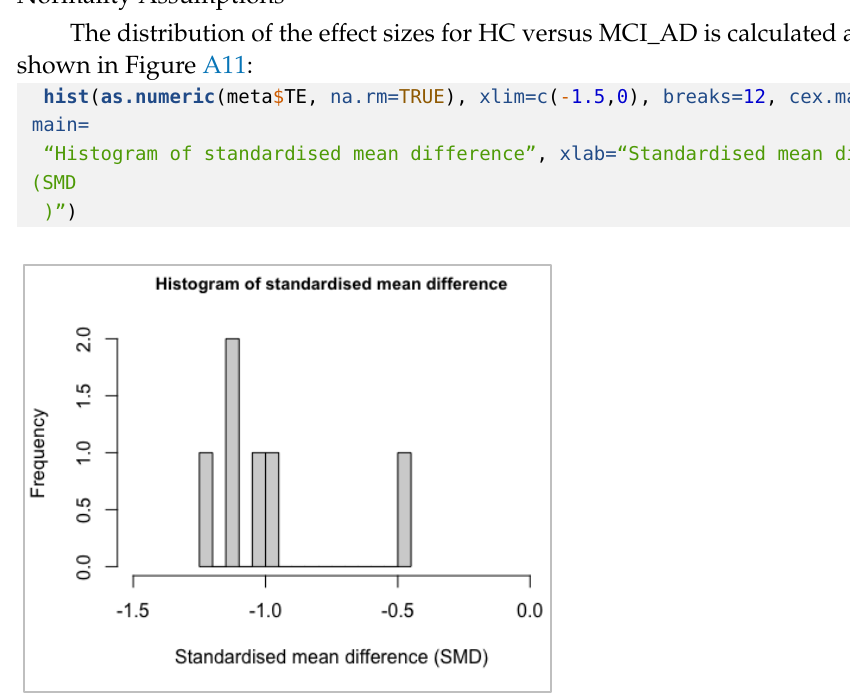
Figure A11. Due to the small number of studies, it is difficult to draw conclusions from the histogram, but there is no clear evidence against the distribution of the SMD of HC versus MCI_AD being approximately normal.